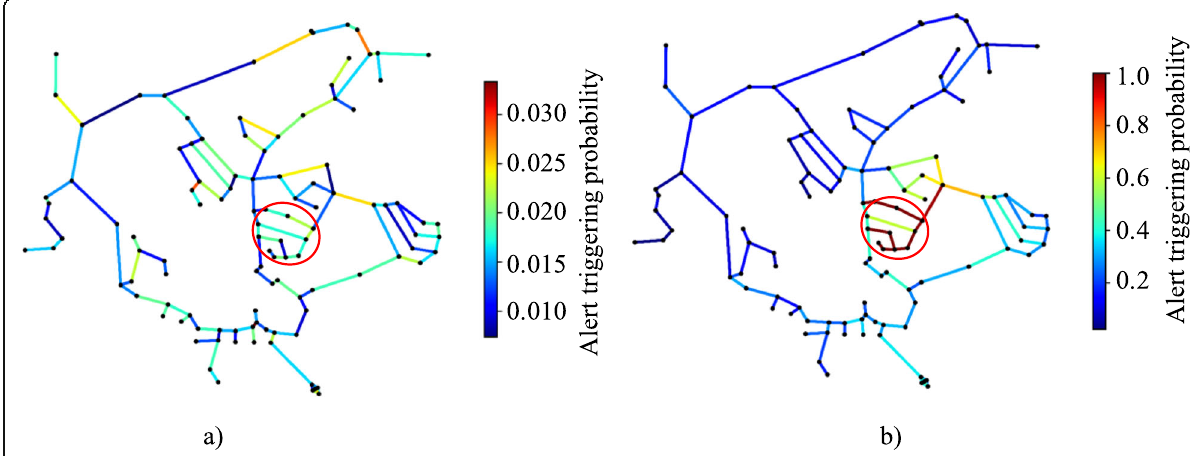
Fig. 11 Probability of AE model triggers leak by individual water pipe in the WSN under a Non-leaking condition, b Leak condition (encircled are the monitoring area where water pressure data is